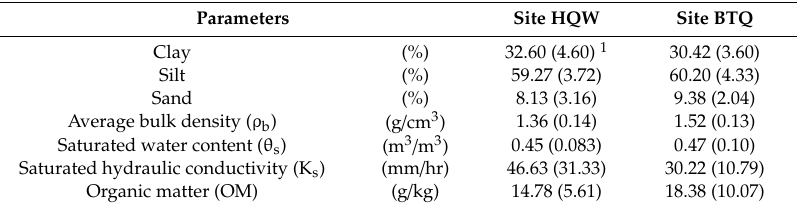
Table 1. Basic soil properties of two